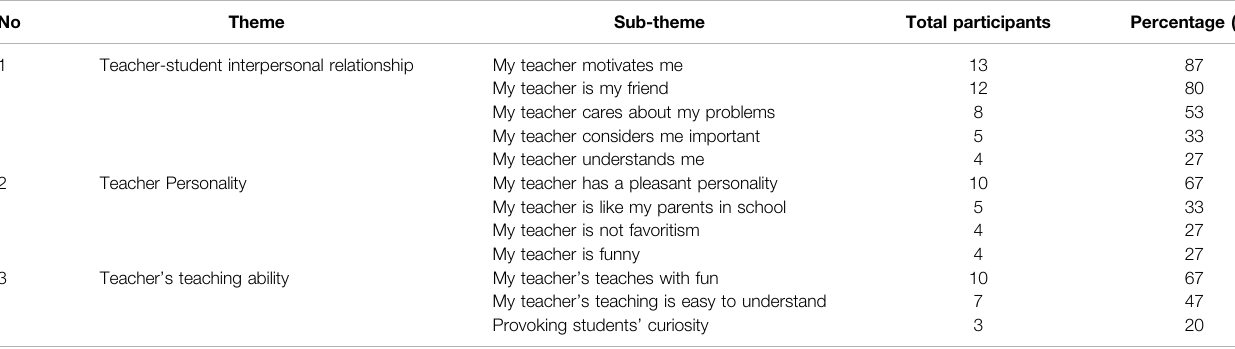
TABLE 1 | Data coding